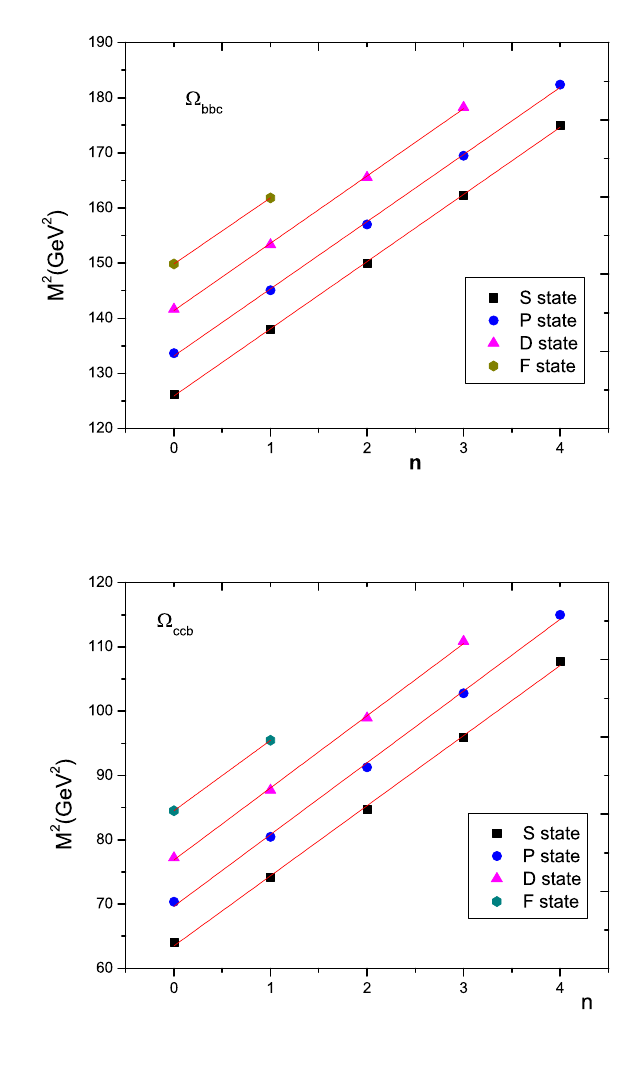
Figure 1. Regge Trajectories in (n, M 2 ) plane for charm-beauty triply heavy baryons [3,